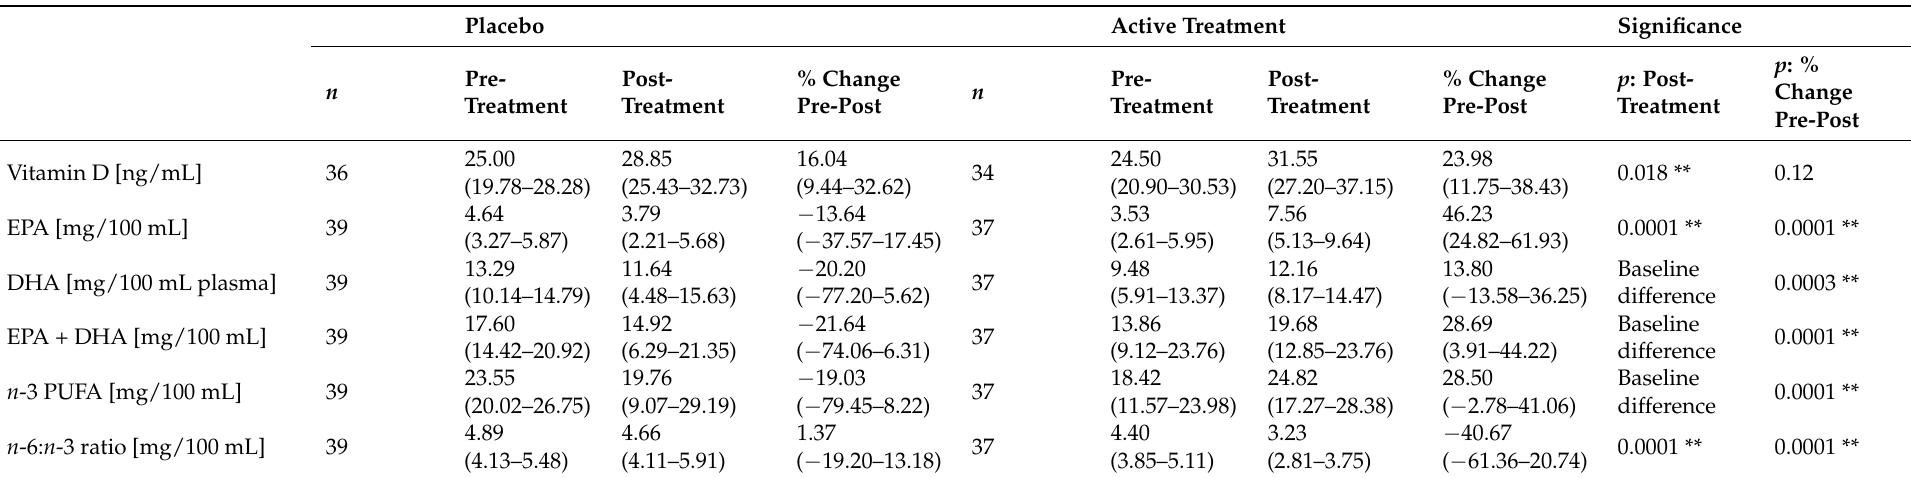
Table 4. Validation of study